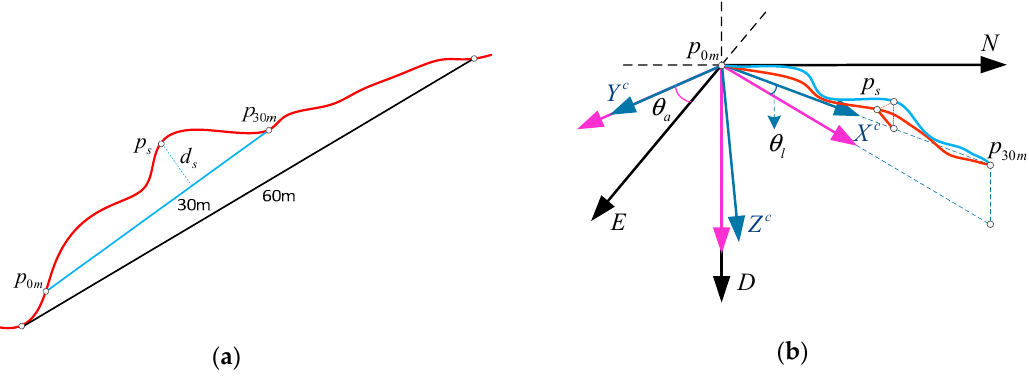
Figure 6. ( a ) Track segmentation and the 30m chord; ( b ) Alignment and level calculated from the navigation coordinate.